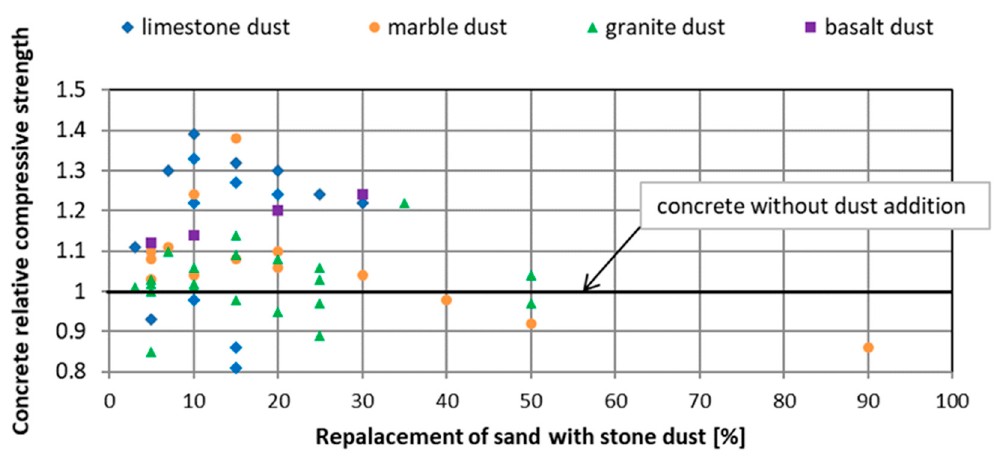
Figure 2. The influence of rock dust on the compressive strength of concrete after 28 days of hardening [12,15–20,22,23,25,26,29,30].